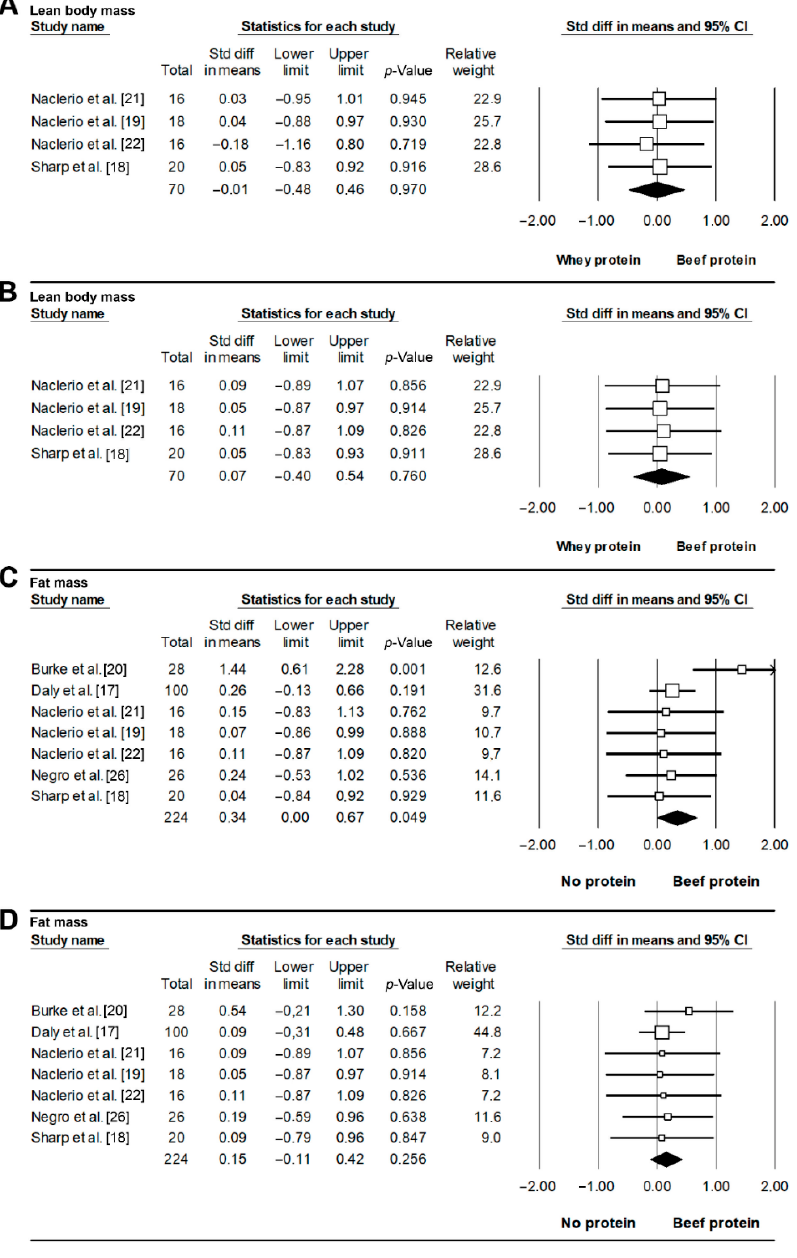
Figure 3. Effects on lean body ( A ) and fat mass ( B ) of beef vs. whey protein supplementation and effects on lean body (panel C ) and fat mass (panel D ) of beef vs. no protein supplementation. Each forest plot displays the pooled standardized difference in means and 95% confidence interval.